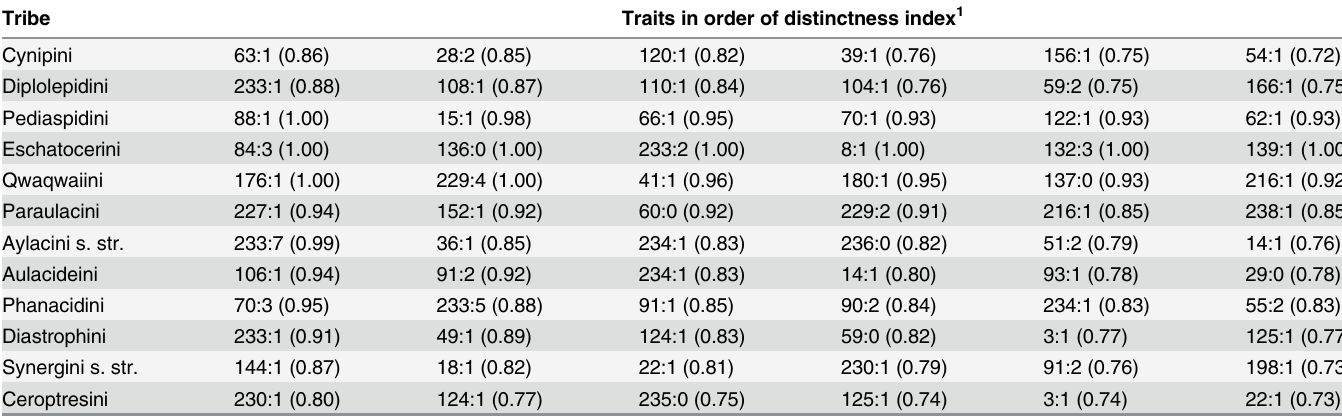
Table 3. Most distinctive traits of the 12 cynipid tribes recognized in this paper. Tribe Traits in order of distinctness index 1